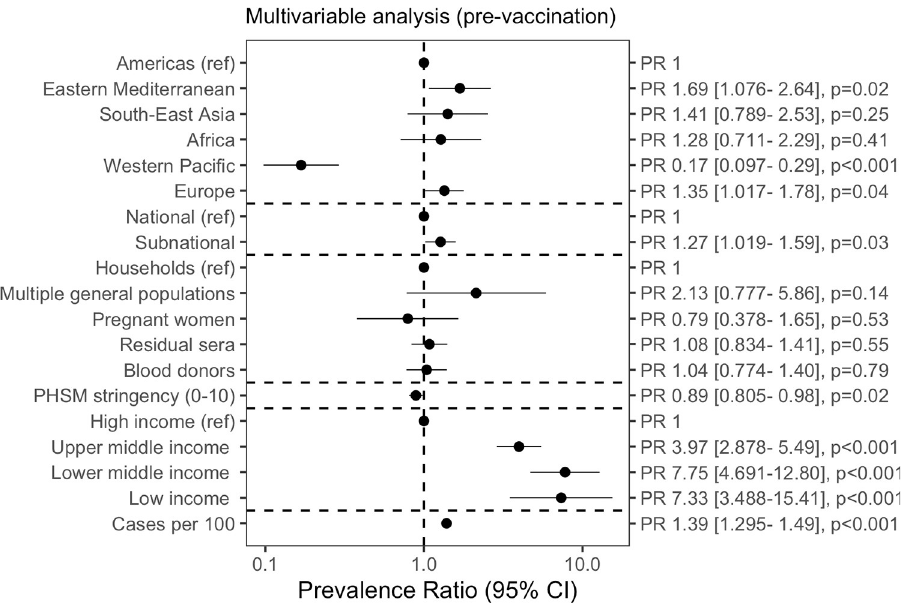
Fig 4. Meta-regression of seroprevalence (prevaccination) to identify study design and country factors associated with seroprevalence. We fit a log-Poisson generalized linear mixed-effects model, including studies where less than 5% of the national population was vaccinated 2 weeks before the sampling midpoint date. We performed model comparison using the AIC criterion (Table G in S1 Materials). PHSM data were taken from the London School of Hygiene and Tropical Medicine global dataset. The PHSM index scale ranged from 0 (least stringent) to 10 (most stringent) (see File H in S1 Materials). k = 329; χ 2 (95% CI) = 0.74 (0.63–0.87). The marginal R2, or variation between studies explained only by fixed effects, was 62.9%. Multivariable analysis included additional controls for transmission phase and age group not shown in figure. AIC, Akaike information criterion; PHSM, public health and social measure; PR, prevalence